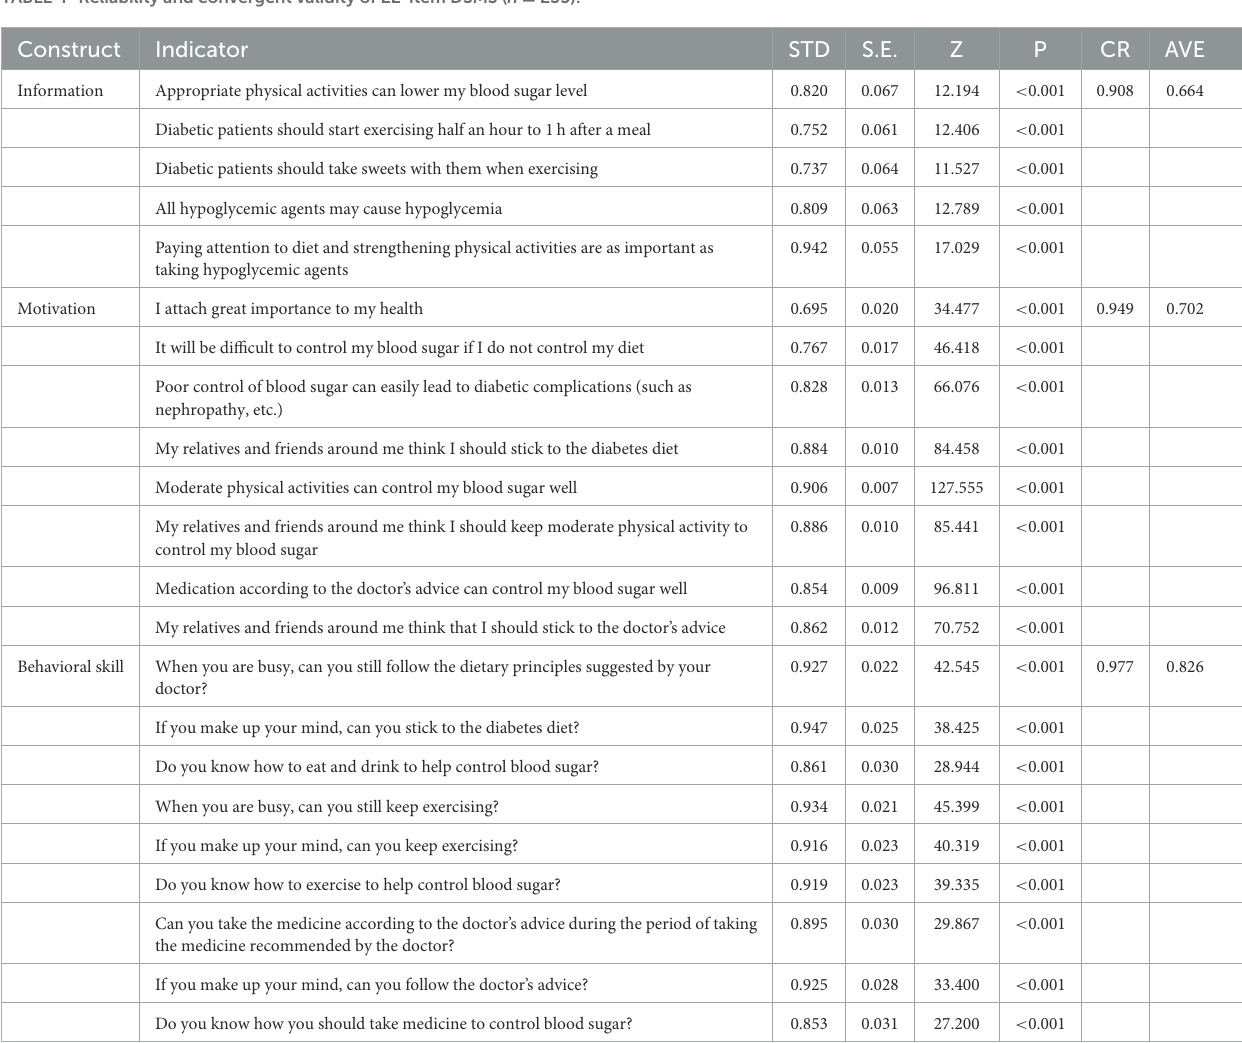
TABLE 4 Reliability and convergent validity of 22-item DSMS ( n =